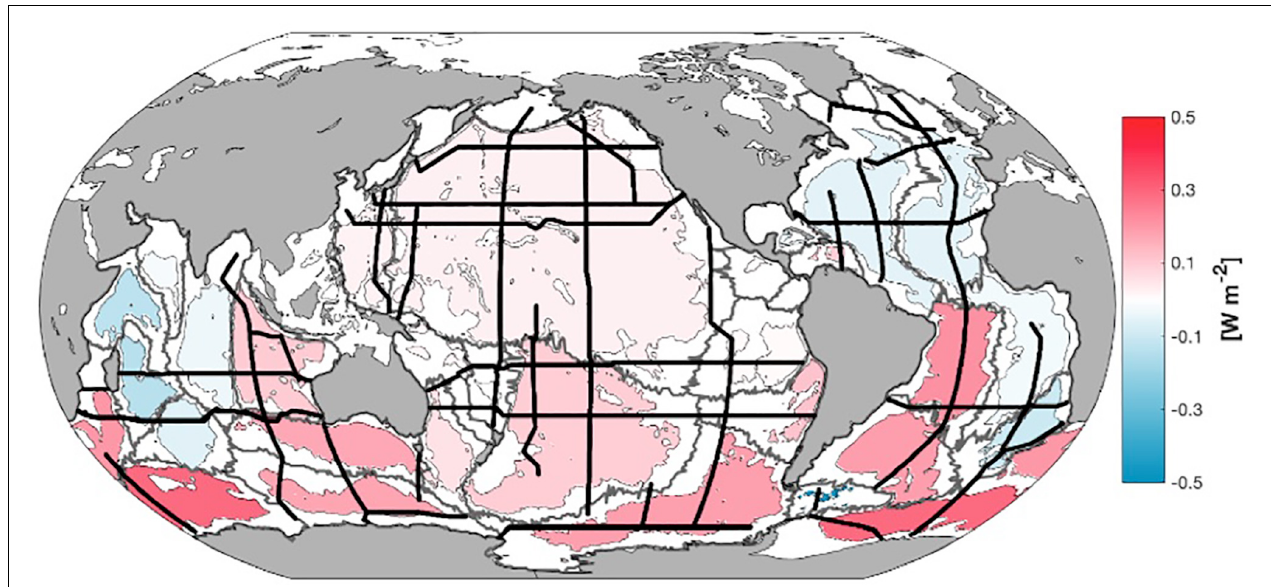
FIGURE 4 | Heat flux (colors) through the 4000 m isobath (thin gray lines) needed to account for the mean local basin (thick gray lines) abyssal ocean warming estimated from GO-SHIP full depth hydrography sections occupied two or more times (black) between 1981 and 2018. Methods follow Purkey and Johnson (2010) with warming rates updated through